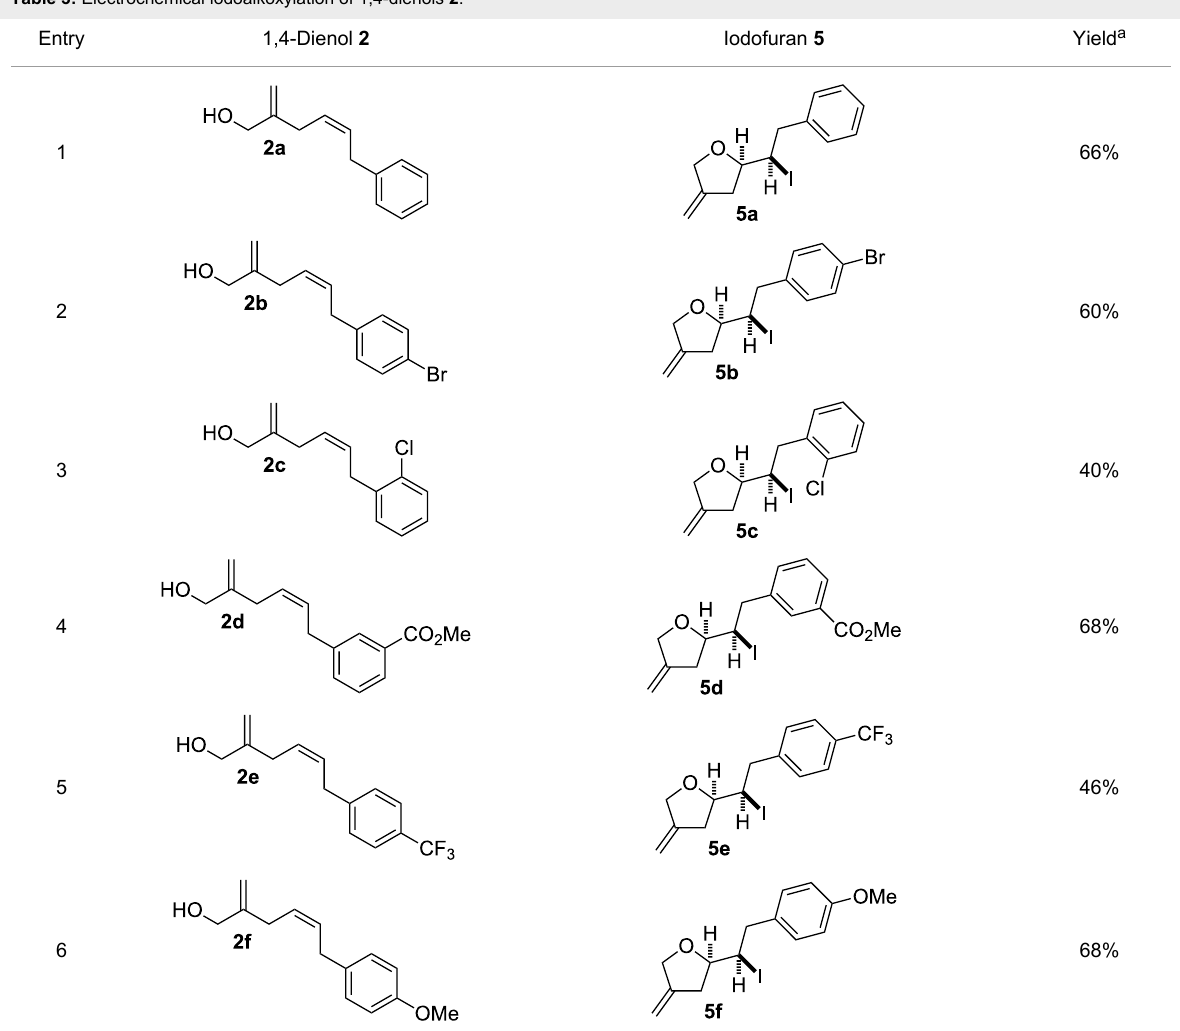
The electrochemical iodoalkoxylation of the aryl-substituted 1,4-dienols 2 led to the formation of the tetrahydrofuran deriva- tives 5 as single regio- and diastereomers. 1,4-Dienols with electron-donating and electron-withdrawing substituents as well as heterocyclic compounds gave the product of type 5 in good yields. It is noteworthy, that under these reaction conditions